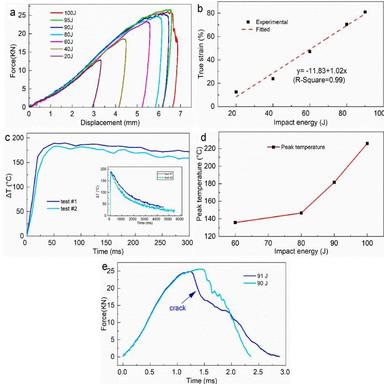
(a) Typical force-displacement curves recorded during drop weight impact testing of the DP 1180 steel with varying impact energy. (b) The relationship between true strain at the top of dome and impact energy. (c) The temperature variation with time recorded by thermal couples during impact testing (90 J). (d) The peak temperature measured during drop weight impact tests vs. impact energy. (e) Force-time cures for drop weight impact testing.